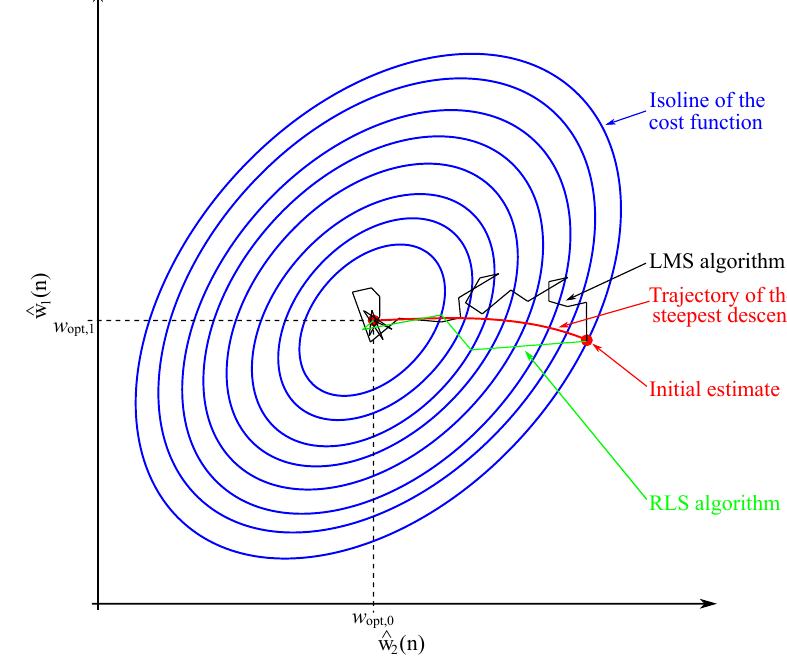
Figure 7. Illustration of the coefficient optimization